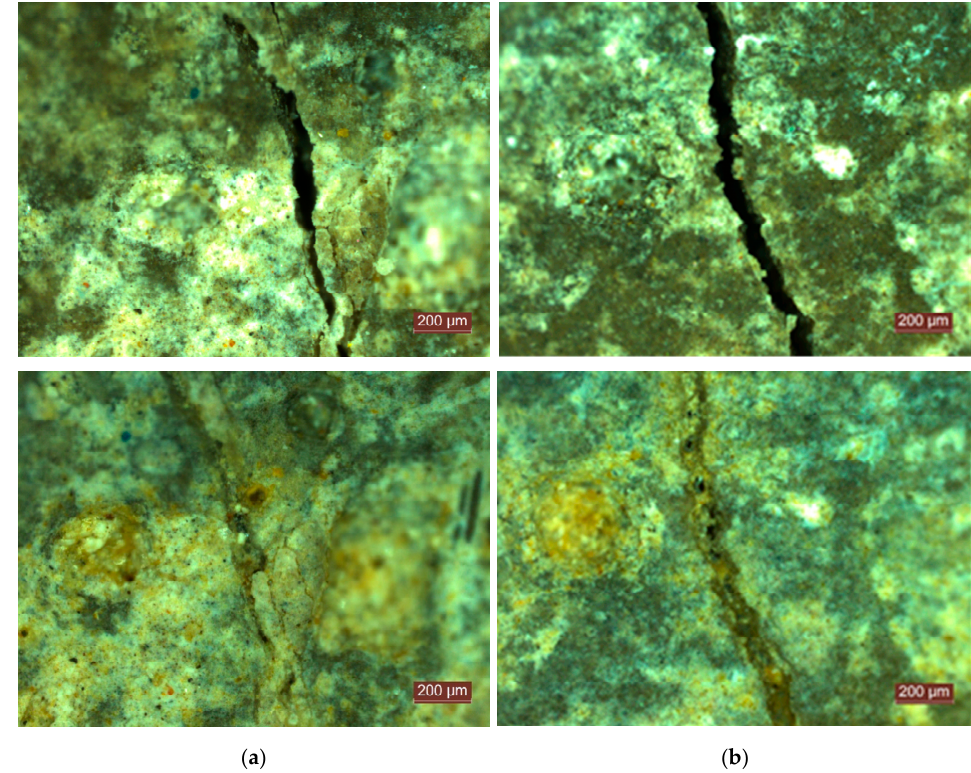
Figure 6. Initial crack and self-sealing products at 20 days of the reference mixes: ( a ) T0r; ( b ) T0c.